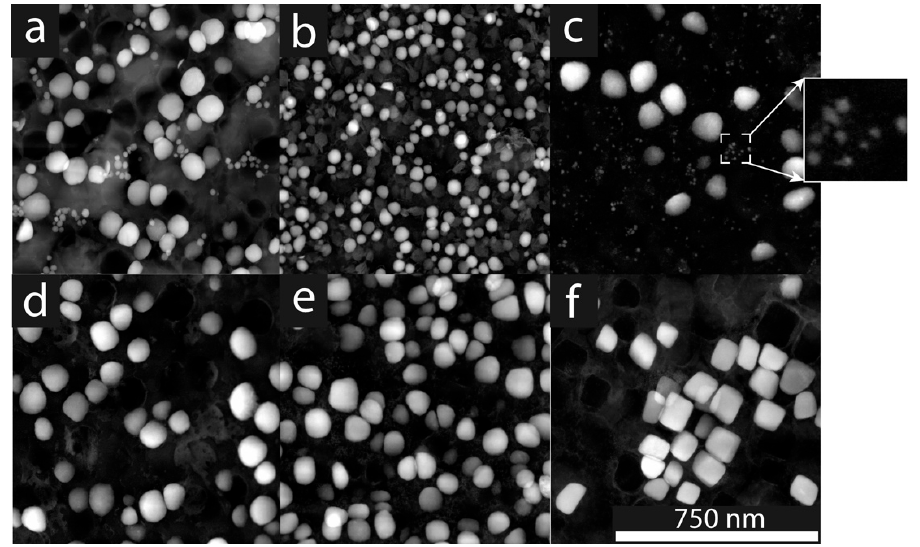
Figure 1. STEM micrographs of carbon replica samples of each alloy in the series, with varying Mo content: ( a ) 0 at.% Mo, ( b ) 1 at.% Mo, ( c ) 2 at.% Mo (with inset showing higher magnification of tertiary γ′ ), ( d ) 3 at.% Mo, ( e ) 4 at.% Mo, and ( f ) 5 at.% Mo.